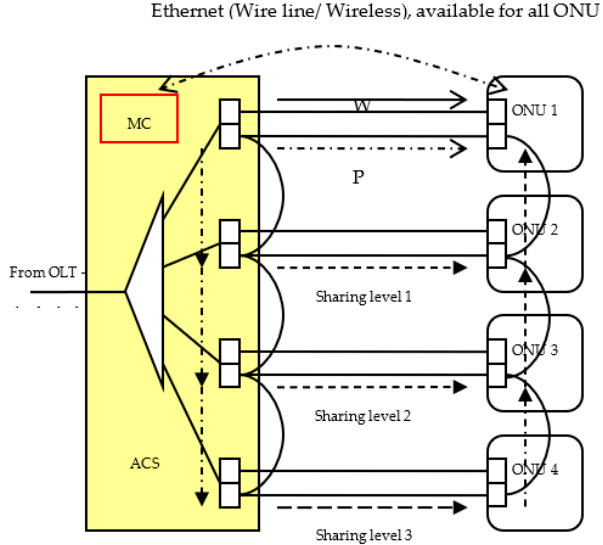
Figure 13. Protection and restoration process flow.